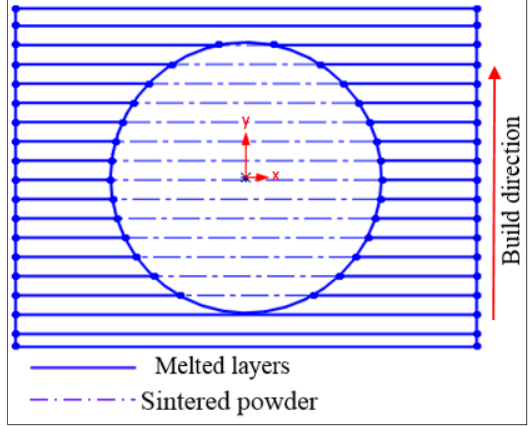
Figure 6. Building of hole by EBM.